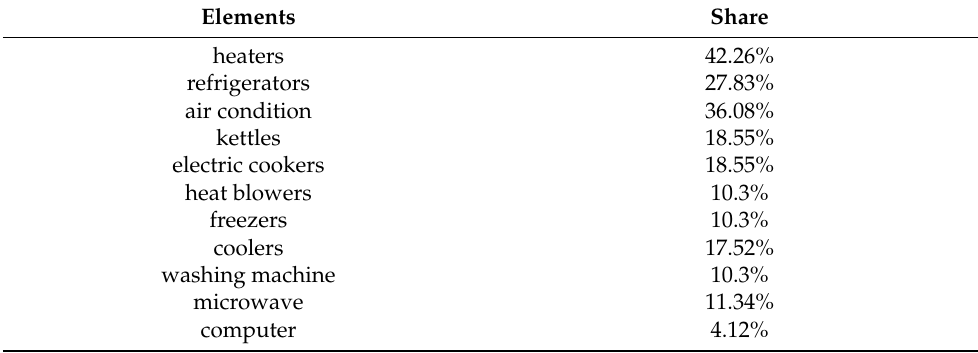
Table 3. Energy consumer in respondents’ home.